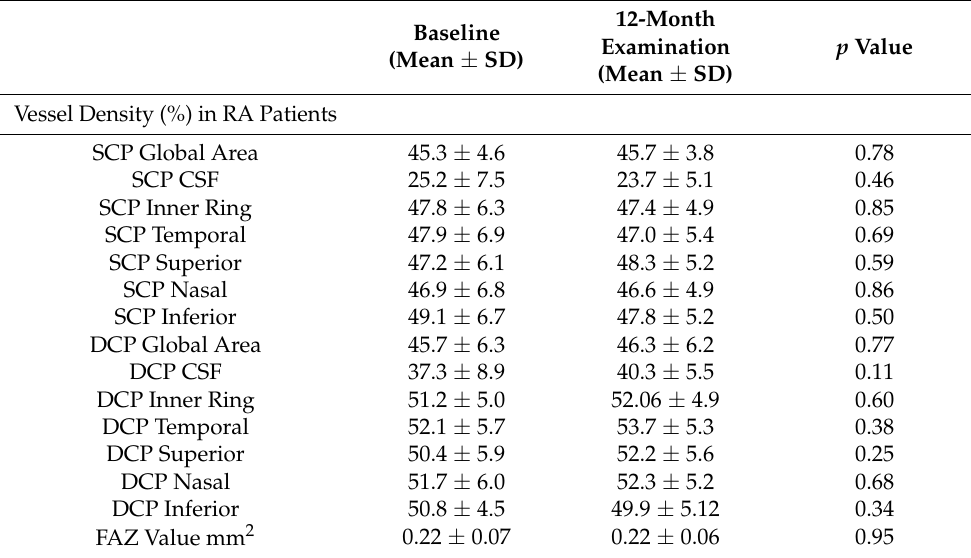
Table 2. Vessel density analysis of superficial capillary plexus (SCP), deep capillary plexus (DCP) and foveal avascular zone (FAZ)